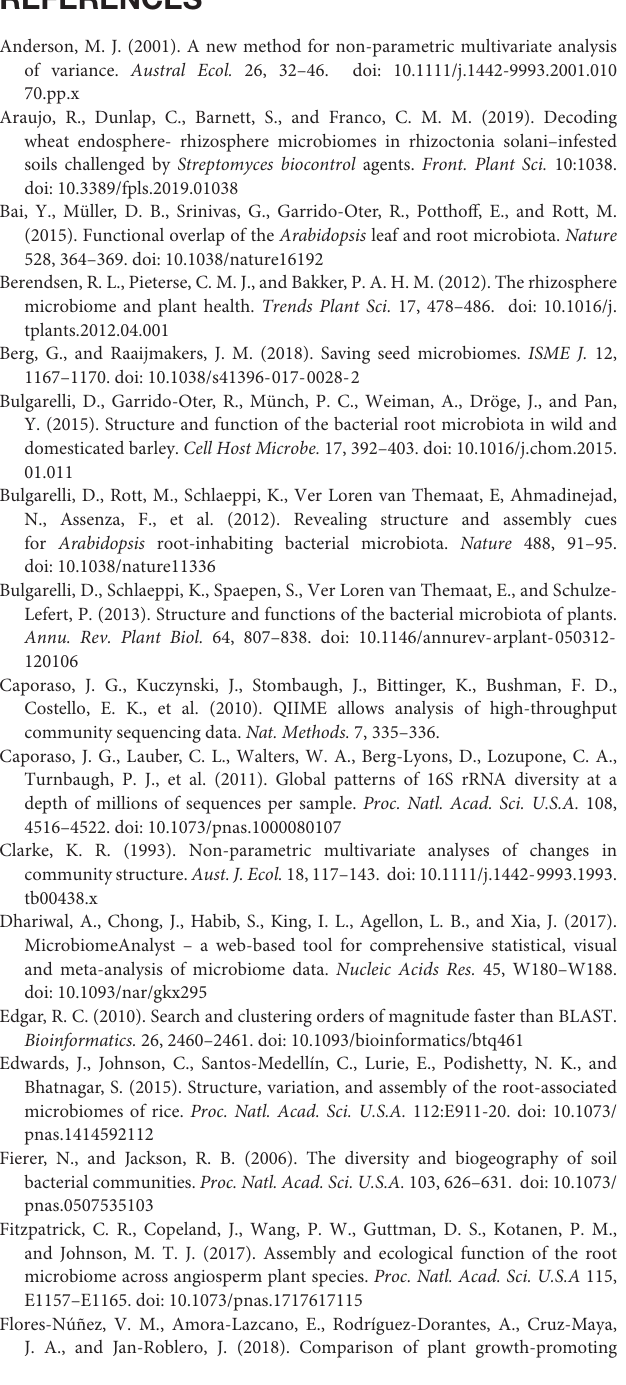
continuous arable soil and solid circles represent bare fallow soil. Red color indicates samples from bulk soil, dark red color indicates samples from wheat rhizosphere, and dark green color represents samples collected from the wheat endosphere. FIGURE S4 | Heatmap showing the 60 significantly differentially abundant OTUs detected using DESeq2 among different land management treatments